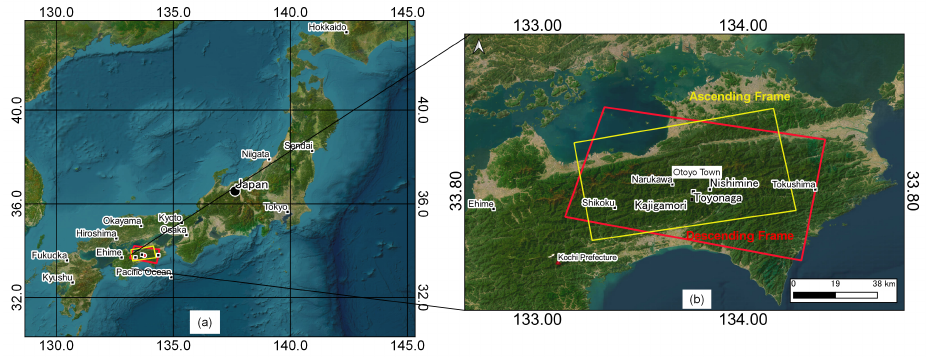
Figure 1. Map of Kochi Prefecture in Japan, including the study area ( a ), the location of Otoyo Town ( b ). The yellow and red rectangles represent the ascending and descending frames from Sentinel-1, respectively.